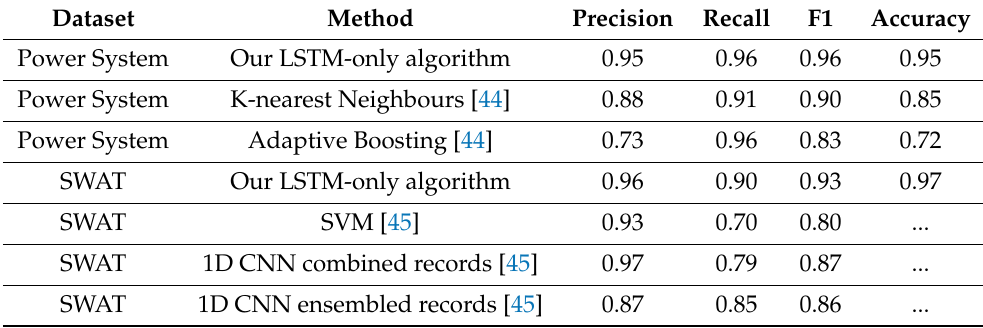
Table 1. Evaluation results of our LSTM-based anomaly detection.